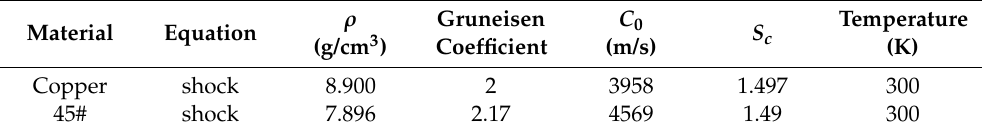
Table 1. Equation of state parameters.